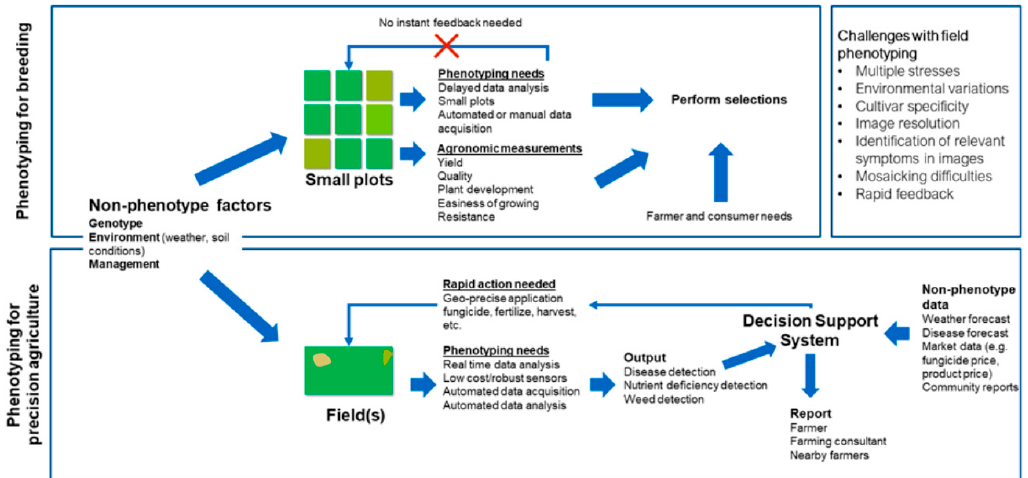
Figure 1. An overview of differences in the phenotyping needs and subsequent actions needed for plant breeding and precision agriculture.